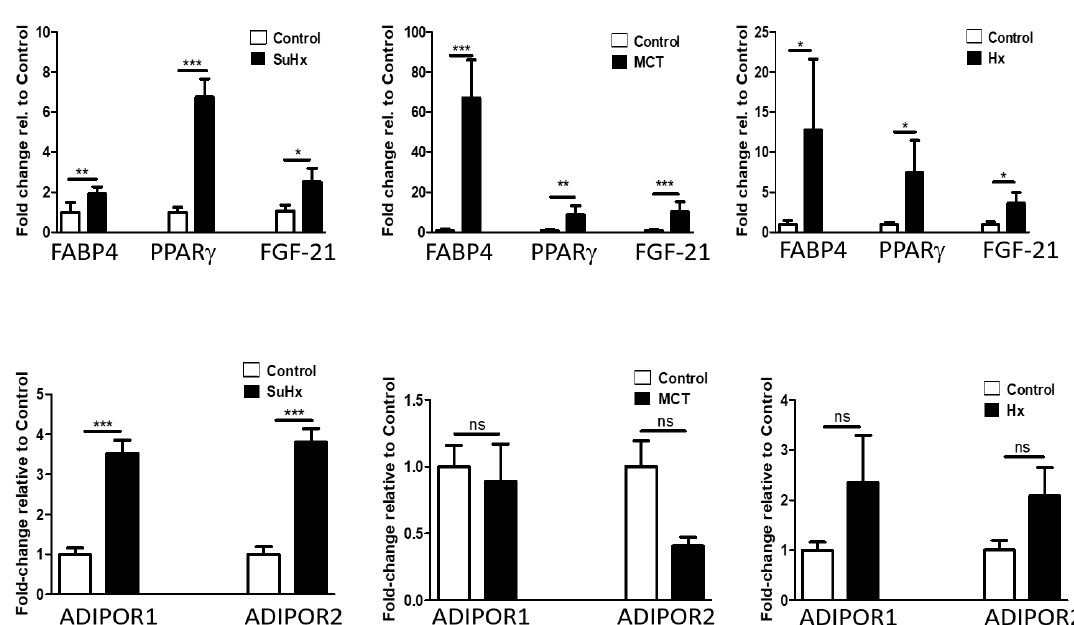
Figure 3. Altered Lung levels of FABP-4, PPAR γ , FGF-21, and adiponectin receptor 1 and 2 mRNA in experimental pulmonary hypertension. Data represent mean ± SEM from n = 5–12 animals per experimental group. Statistical analysis by Student’s t -test. * p < 0.05, ** p < 0.005, *** p < 0.001, ns: no significant.